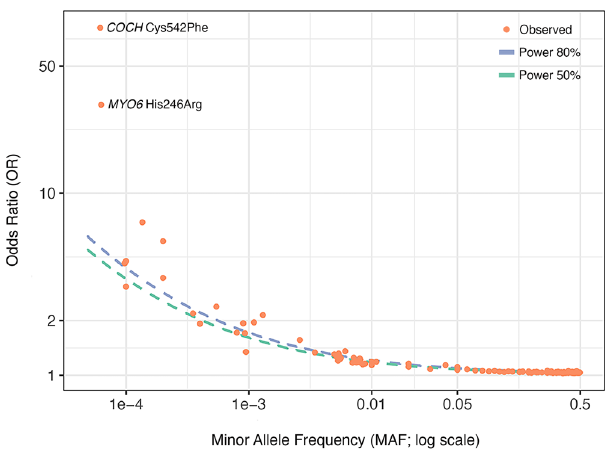
Fig. 5 Effect size and allele frequency for variants associated with adult hearing loss. Plotted are odds ratio estimates (on log scale) and minor allele frequencies of genome-wide signi fi cant variants and gene burdens (Supplementary Data 2, 6 and 7). 50% and 80% power curves for the present study are plotted as dotted lines. Notably, almost all points (particularly low-frequency and common variants, MAF > 0.0005) lie very close to the dotted power